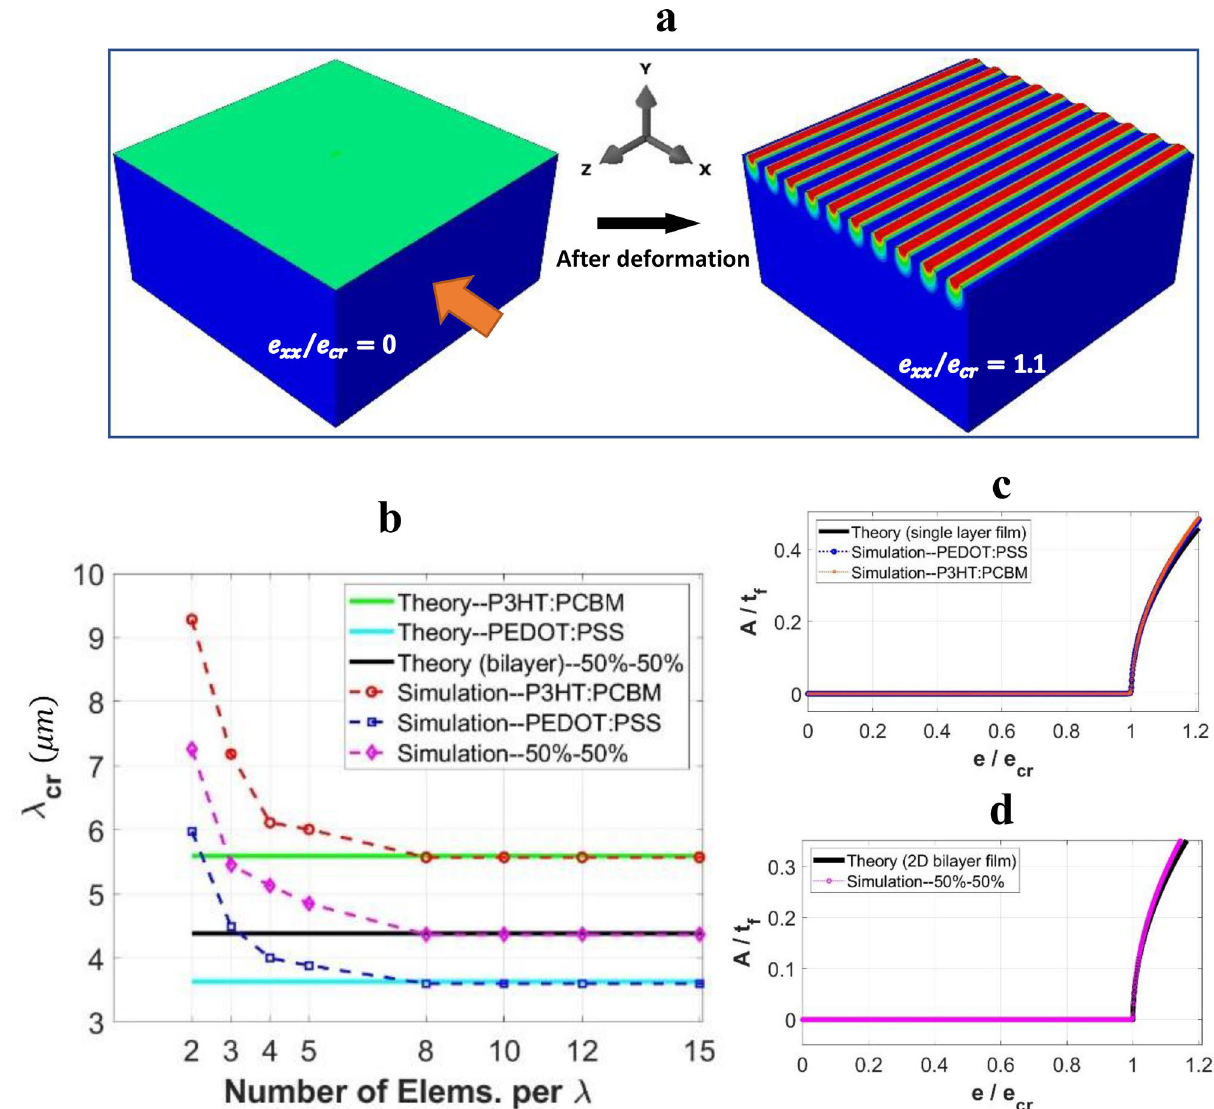
Figure 2. ( a ) Typical form of simulated 1D wrinkles associated with the converged mesh. ( b ) Variation of simulated 1D wrinkling wavelength with the number of elements per analytical wavelength. ( c, d ) Amplitudes of the sinusoidal wrinkles normalized by film thickness as a function of the applied strain normalized by the critical value, plotted for ( c ) single-layer, and ( d ) bi-layer film